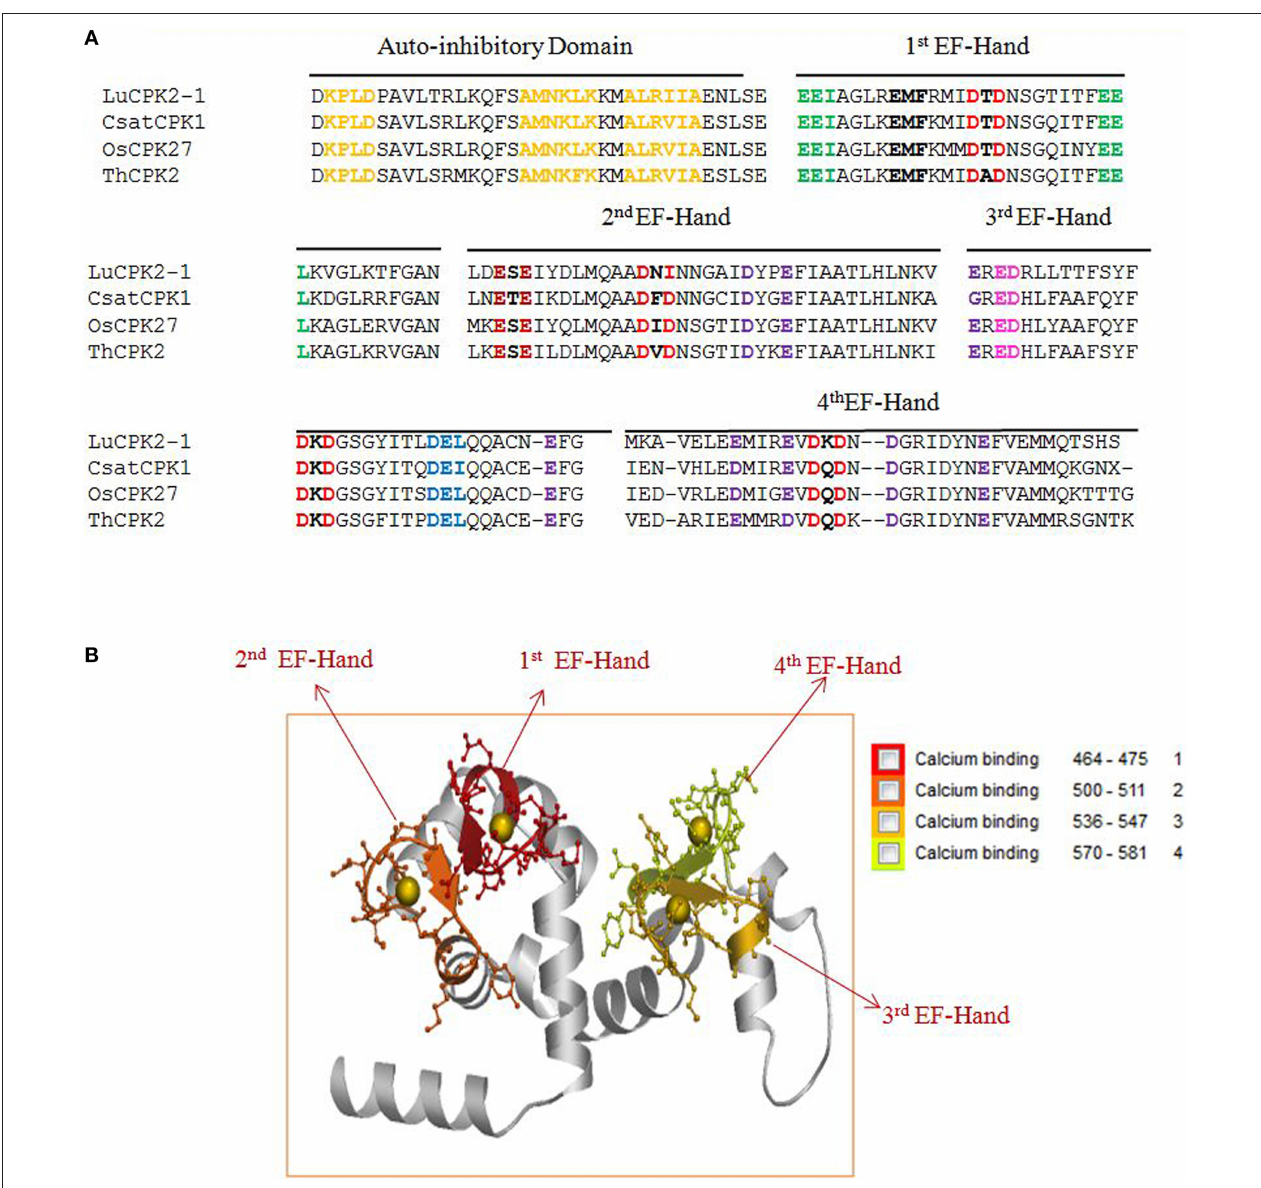
FIGURE 3 | (A) The presence of conserved domains and motifs in auto-inhibitory and EF-hand regions of calcium-dependent protein kinases (CPKs) in plants. The auto-inhibitory domain contains K-P-L-D, A-M-N-K-L-K, and A-L-R-I-I-A conserved sequences (orange). The EF-hand regions of the regulatory domain of CPK have D-x-D (red) and D/E-E-L motifs (light blue). Higher plants contain four D-X-D motifs in their EF-hands, while lower eukaryotes have only two D-x-D and one D-x-x-E motif. Other motifs found in the EF-hands include E-E-I and E-E-L (green). The presence of the conserved motif E-E-I/x (green) at position 1, 2, and 3, as well as E-M-F at position 8, 9, and 10 (bold black) are first EF-hand specific. The E-x-E motif (dark red) at position 3, 4, and 5 is second EF-hand specific, while the x-E-D motif at position 3 and 4 (pink) is third EF-hand specific. The presence of conserved D/E at position 11 and 12 is fourth EF-hand specific. Some conserved D and E residues present in the EF-hand regions of plants are indicated in purple. Complete details regarding the conserved domains of CPKs can be found in the Supplementary Figures. (B) Three dimensional structure of the EF-hand domain of plant CPK (AtCPK1). The structure was created using the Swiss-Model workspace (http://swissmodel.expasy.org) for AtCPK1 as a representative sequence. The colored boxes in the bottom represent the presence of calcium binding motifs within the specific region of EF-hands. Regions ranging from amino acids 464–475, 500–511, 536–547, and 570–581 belong to the first, second, third and fourth EF-hands respectively. All calcium binding EF-hands start with the D-x-D motif. The starting regions of all calcium-binding EF-hands contain conserved D-x-D motif and ends with conserved glutamic acid (E). The conserved D-x-D motif present at position 14, 15, and 16 and conserved E residue is present at position 25 in each EF-hand. Therefore, amino acids 14–25 of each EF-hand are assumed to play crucial roles in calcium binding activity. In conclusion, EF-hands contain conserved aspartic acid (D) and glutamic acid (E) residues, which may be critical to accessory signaling in calcium binding.